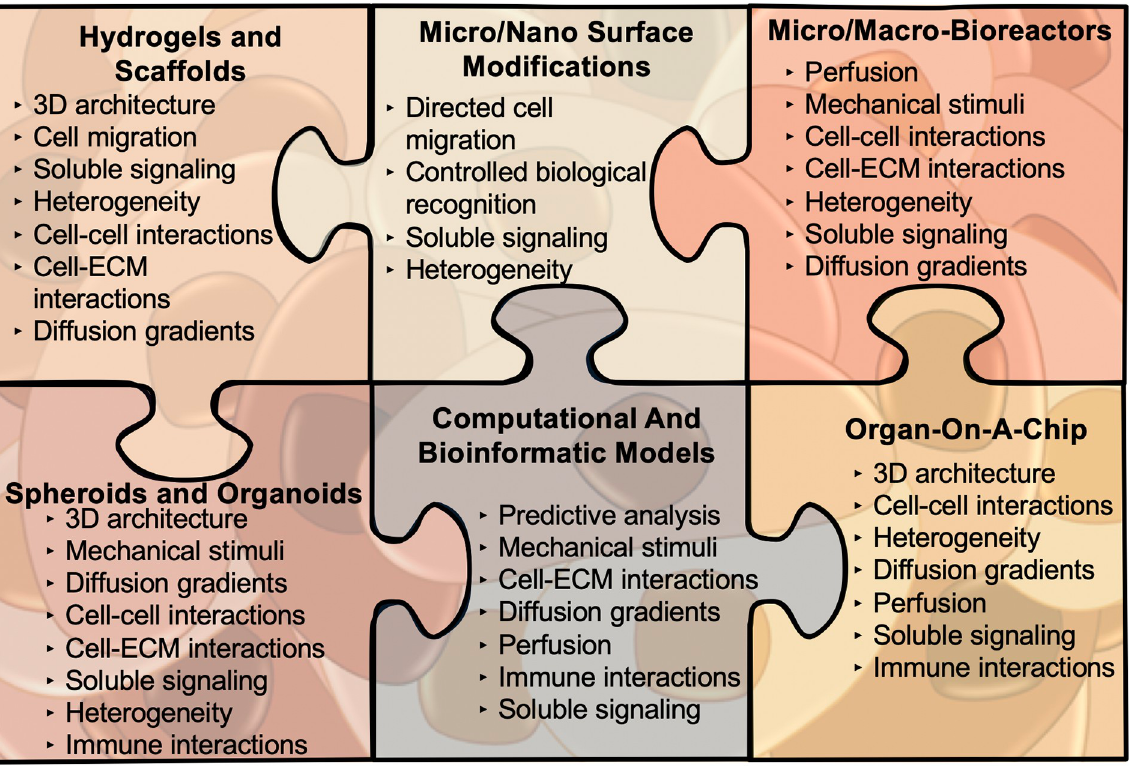
Fig 2. Various engineering tools can help construct the complex picture of the ‘cancer-organ’ system. Summarized here are the state-of-the- art cancer bioengineering models that we discuss in this review. Each model has inherent benefits and drawbacks that are discussed in more detail within the following sections. We have listed the components of the ‘cancer-organ’ system which can be probed with the specific model in the figure.